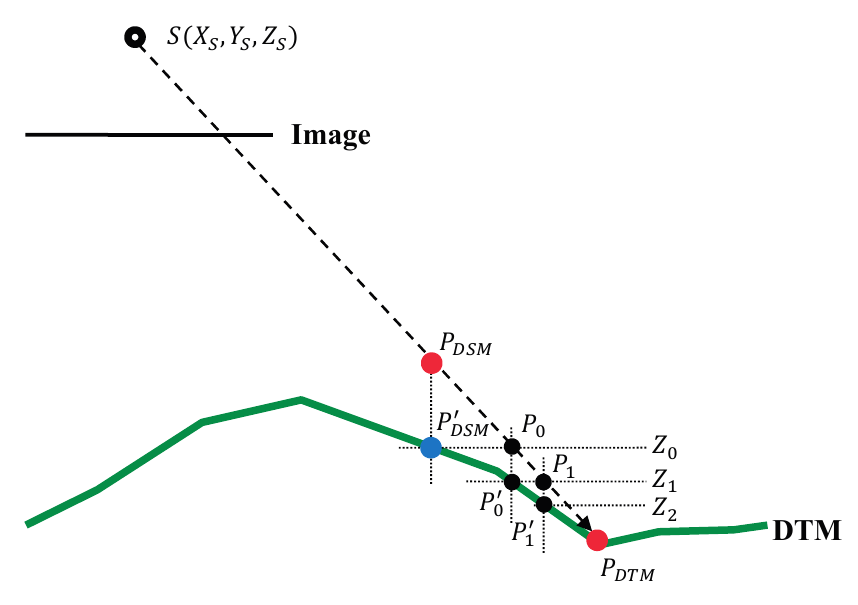
Figure 3. Iteration process of calculating the intersection point of (cid:1845)(cid:1842)